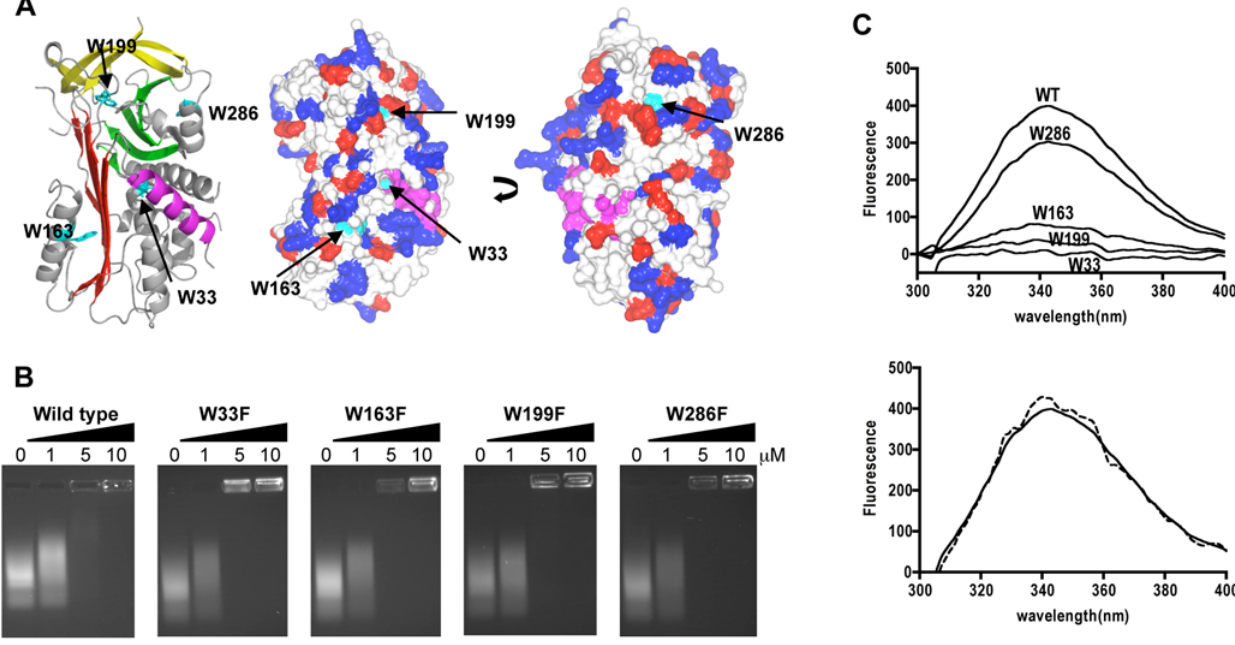
Figure 1. Deconvolution of the tryptophan emission spectra of MENT. (A) Structure of native wild type MENT showing the location of the four tryptophan residues. Cartoon of the location of the four tryptophan residues in the structure of native wild type MENT (2H4R.pdb; McGowan et al. 2006) also showing the A b -sheet (red), B b -sheet (green) and C b -sheet (yellow), D-helix (magenta) and helices hA-hI (grey). The electrostatic potential surface of native wild type MENT (CC4MG, [22,23]) with tryptophan residues shown in cyan and the D-helix in magenta. (B) Chromatin association assays with increasing concentrations of wild type MENT and tryptophan variants. The final concentration ( m M) of purified protein, as indicated at the top of each panel, added to soluble erthrocyte chromatin (OD 260 =1.6). (C) Deconvolution of the fluorescence emission of wild type MENT. The deconvolution of the spectrum of MENT (0.2 m M) into contributions of individual tryptophan residues. The independent behaviour of tryptophan residues in MENT where the solid line is the spectrum of the wild-type MENT (0.2 m M), and the dashed line represents one-third of the sum of the spectra of individual tryptophan variants.